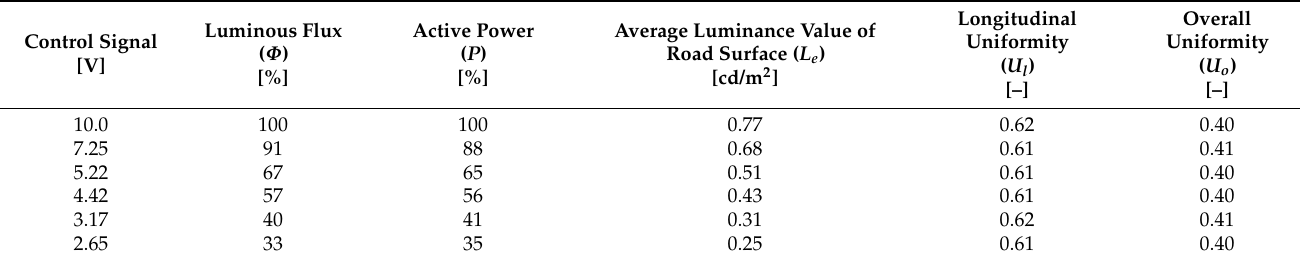
Table 11. Summary of results of average luminance values for different levels of LED_26W luminaires’ control on the tested